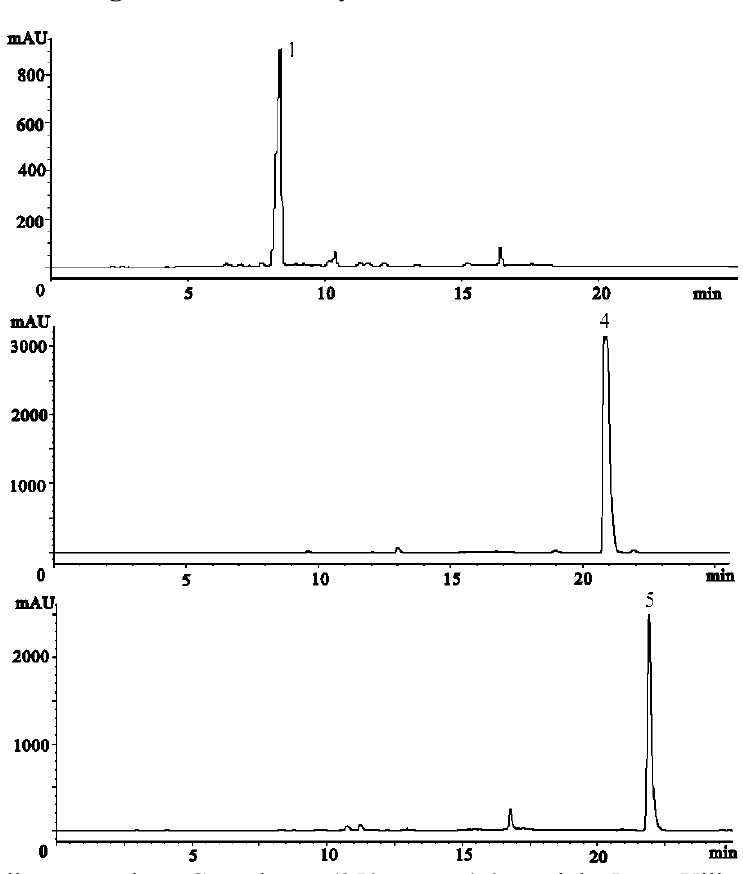
Figure 4. HPLC analysis of CCC fractions